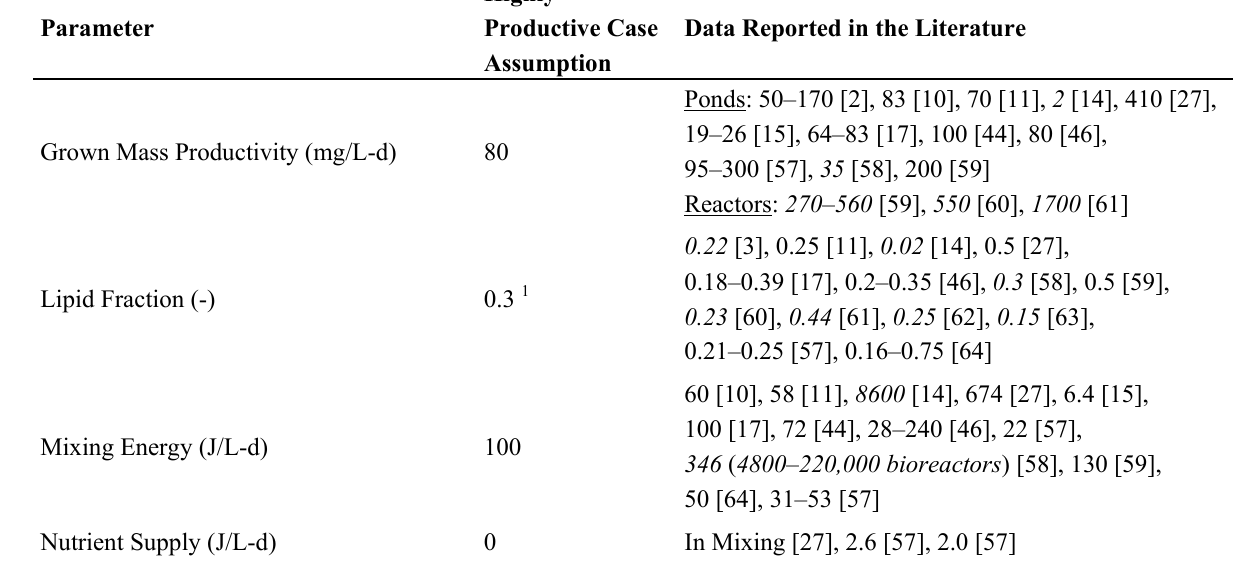
Table 5. Comparison of the Highly Productive Case with data reported in the literature. Experimentally-based data are shown in italic